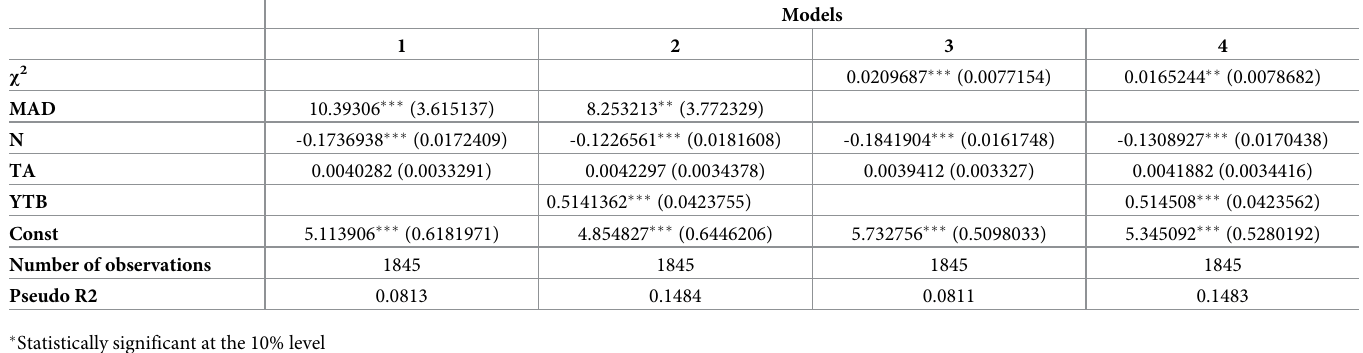
Table 2. Logit regression